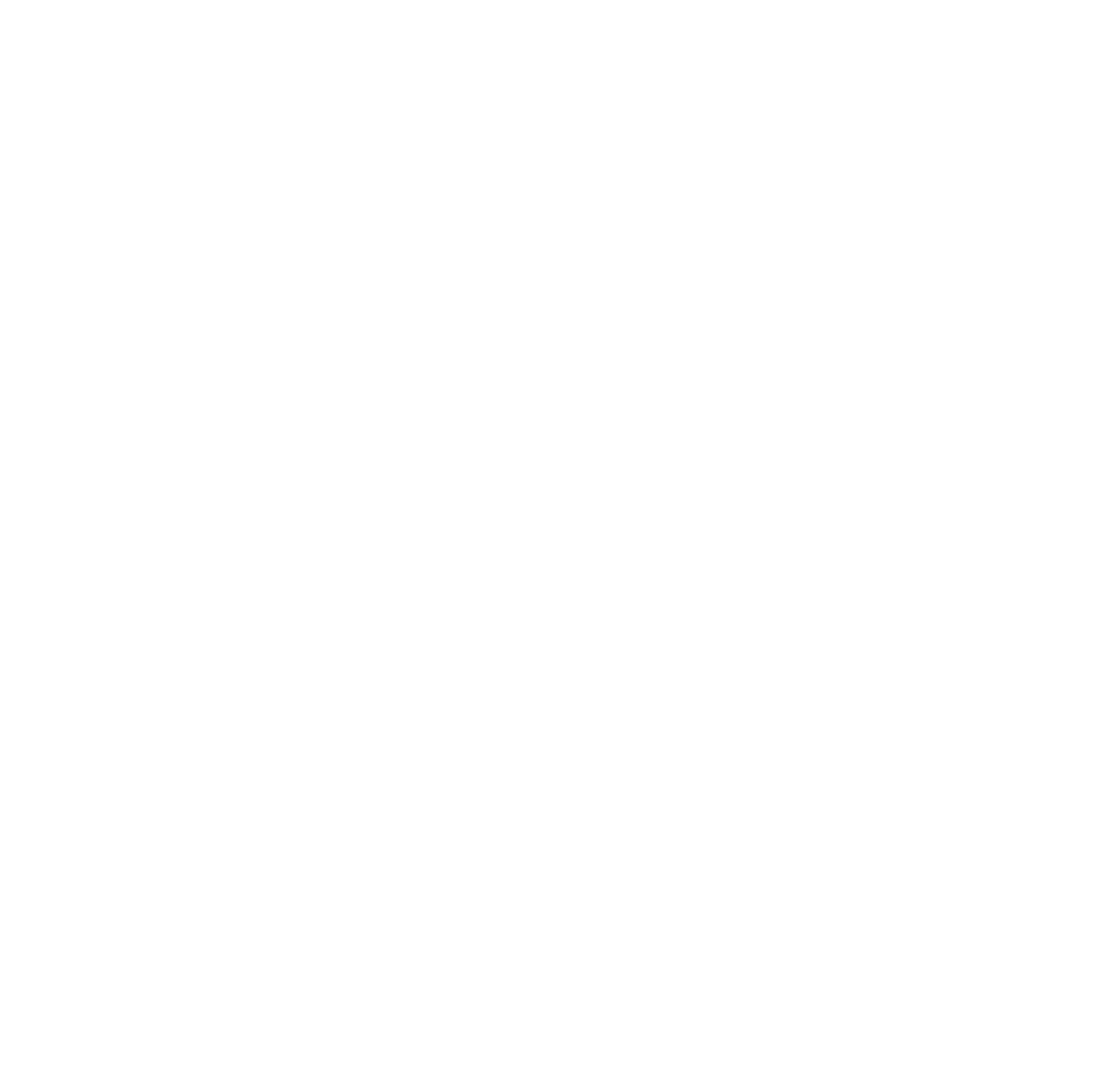
FIGURE 3 | The following/follower ratio was linearly related with MEP